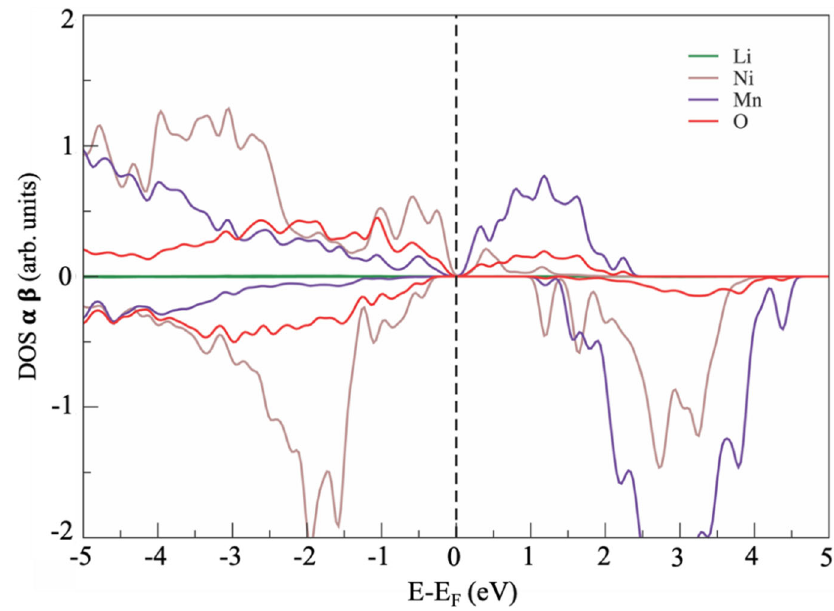
Figure 2. Atom-projected density of state (PDOS) for optimized Li 1.2 Ni 0.2 Mn 0.6 O 2 (LNM) Figure 2. Atom ‐ projected density of state (PDOS) for optimized Li 1.2 Ni 0.2 Mn 0.6 O 2 (LNM) phase.